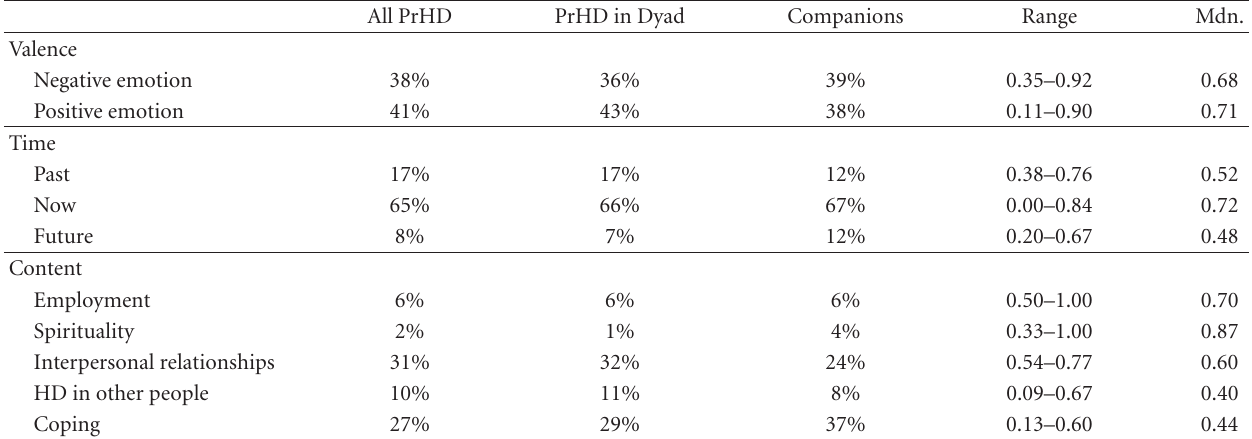
Table 1: Percentage of codeable statements and kappa agreement for content, time, and emotion codes.